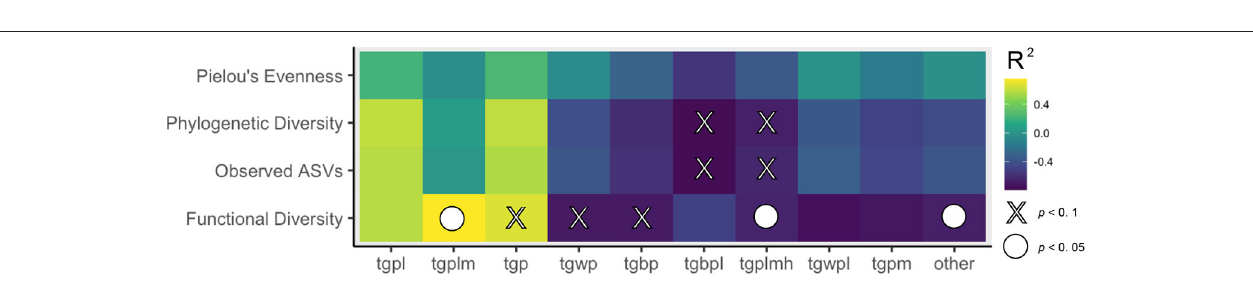
FIGURE 7 | A. Heatmap of Permutational correlation coefficients where lighter colors indicate magnitude of the correlation. X indicates a statistically significant p -value after Bonferroni correction. STURLA Code elements: t, trees; g, grass; p, pavement; b, bare; w, water; l, lowrise; m, midrise; h,